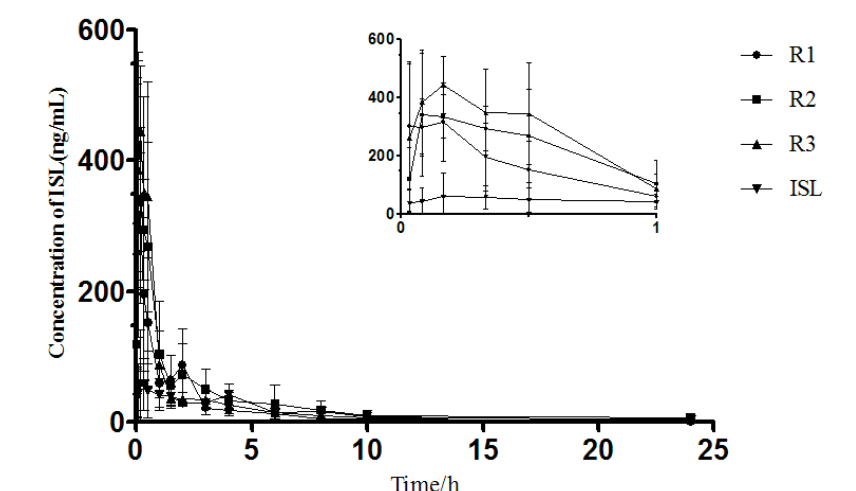
FIGURE 4 - Plasma concentration-time curves of the ISL solution and ISL nanocrystals R1 (mPEG2000-PCL1140), R2 (mPEG2000-PCL2000), and R3 (mPEG5000-PCL5000) in Sprague Dawley rats after oral administration (mean ± SD, n =